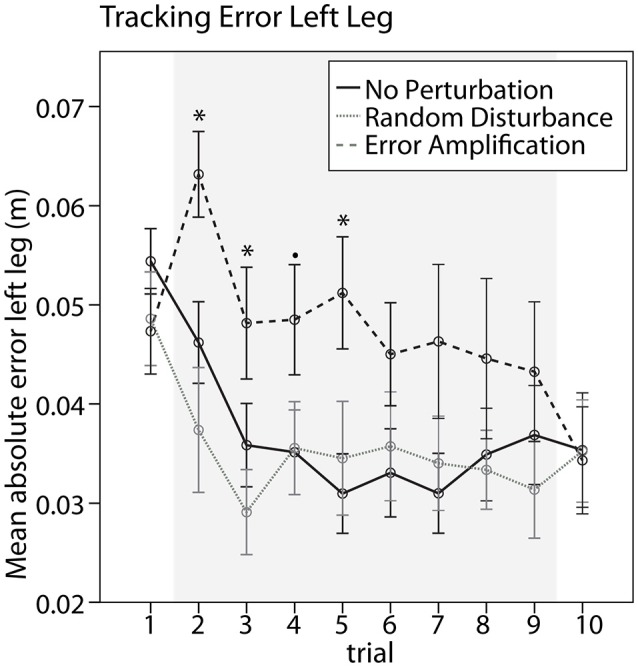
Performance during training. Mean absolute tracking error created with the left leg during baseline (trial 1), training with the different strategies (trials 2–9, shaded area), and retention (trial 10). Error bars show ± 1 CI. *p < 0.05, •p < 0.1.